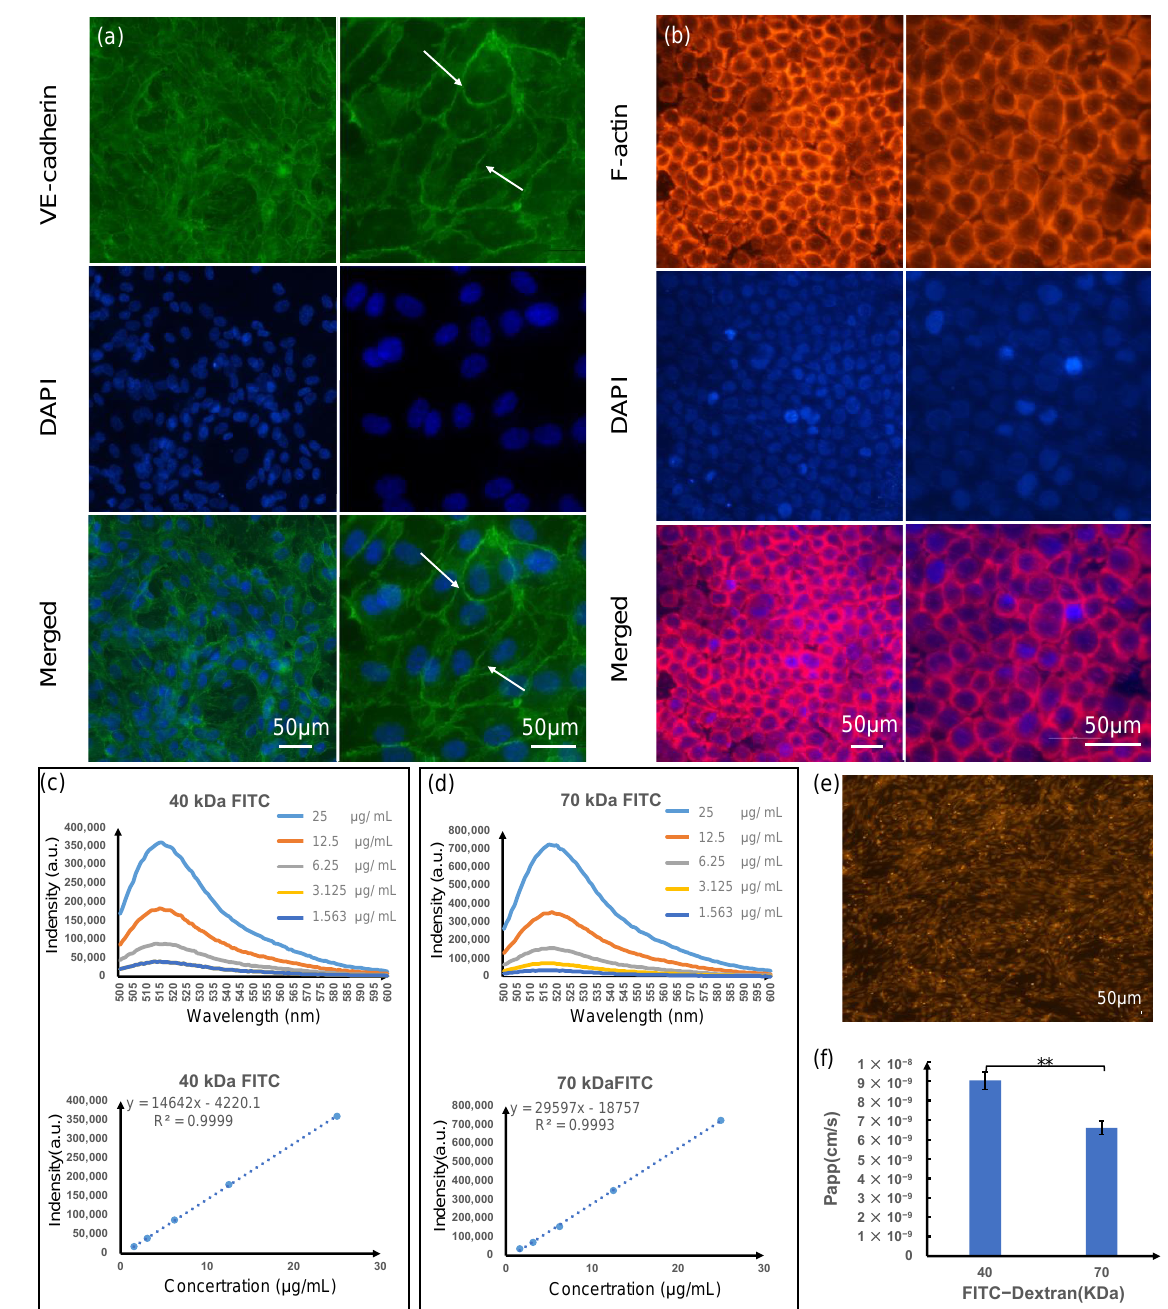
Figure 6. Biological characterization of the two types of epithelium − capillary interface cells on chip. ( a ) Representative images of the expression of tight junction protein VE-cadherin (green) and DAPI (blue) of HUVEC; ( b ) the cytoskeleton of HGECs on membrane (red; stained with F − actin) are visualized with nucleus (blue; stained with DAPI); ( c ) the emission spectra and fluorescence intensity (emission at 518 nm) of different concentration standards of the 40 kDa FITC − dextran; ( d ) the emission spectra and fluorescence intensity (emission at 518 nm) of different concentration standards of the 70 kDa FITC − dextran; ( e ) the fluorescence image of the HUVEC cells layer (stained with celltracker TM orange) on the porous membrane; ( f ) the apparent permeability (P app ) of soluble reagents with 40 kDa and 70 kDa molecular weight FITC − dextran through the HUVEC cells layer, n = 3. Error bars represent the standard error of the mean (SEM) of three independent experiments. Two-tailed significance was set to ** p <